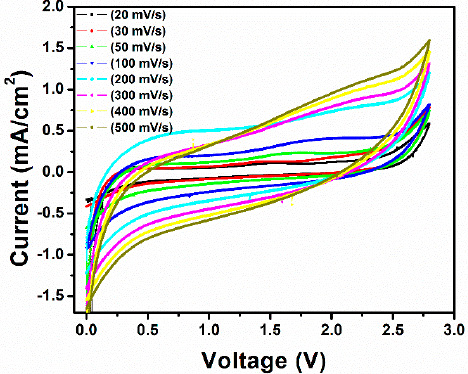
Figure 4. Cyclic voltammogram of TiO 2 nanotube arrays at different scan rates, from 20 to 500 mV/s.